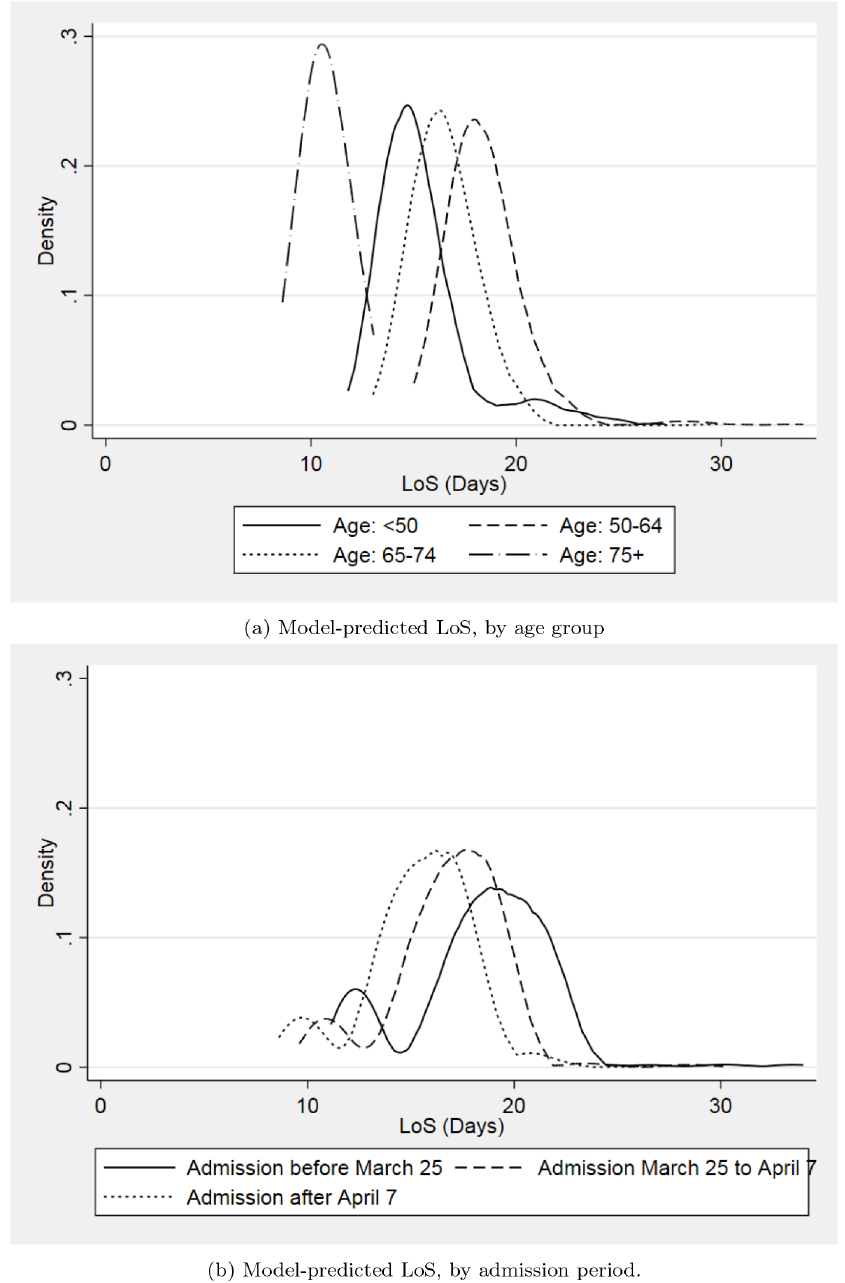
Figure 1: Distribution of mean predicted LoS in